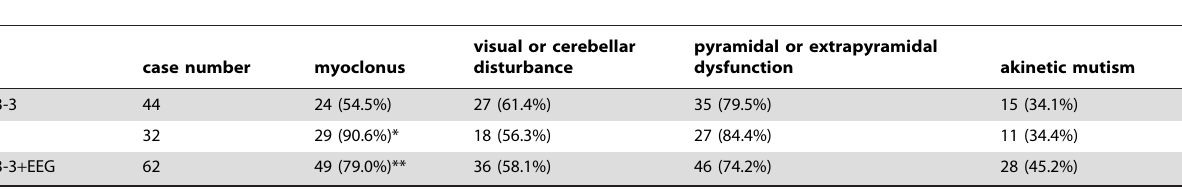
Table 4. Comparison of the results of 14-3-3 and EEG with the appearances of clinical manifestations in 138 probable sCJD patients with two examinations.